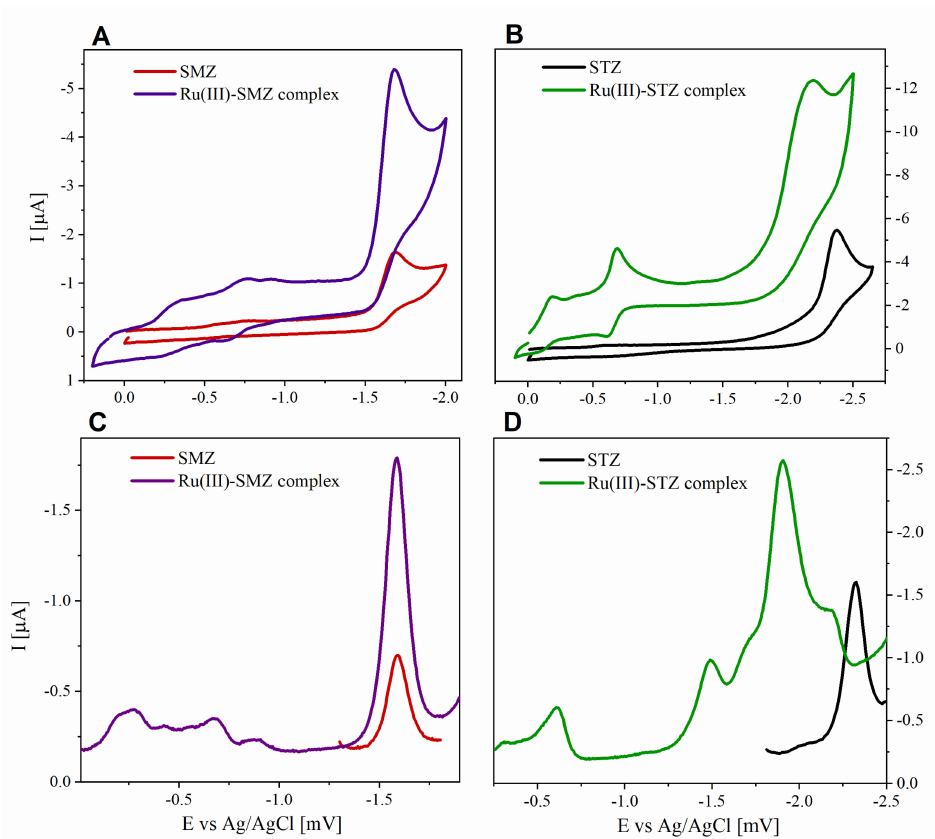
Figure 6. Voltammograms registered for studied ligands and complexes (concentration of 2 · 10 − 3 M) in DMSO ( A ) CV of SMZ and Ru(III)-SMZ complex ( B ) CV of STZ and Ru(III)-STZ complex ( C ) DPV of SMZ and Ru(III)-SMZ complex ( D ) DPV of STZ and Ru(III)-STZ